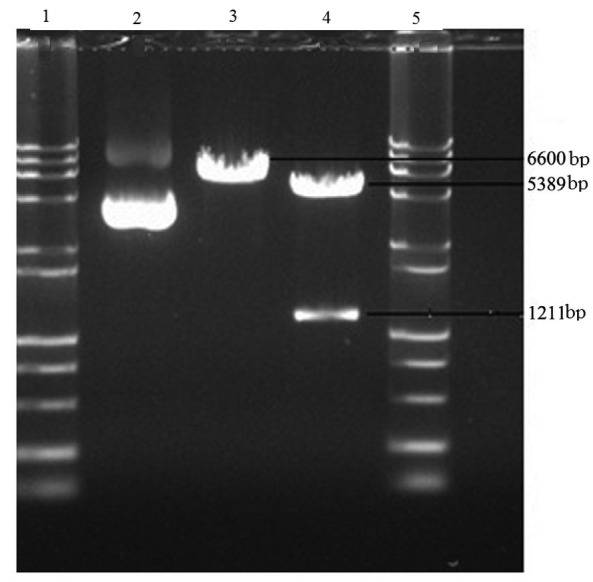
Enzyme electrophoresis of pcDNA3-BMP2. Lanes 1 and 5, DL 15000+2000; lane 2, pcDNA3-BMP2; lane 3, pcDNA3-BMP2/NotI; lane 4, pcDNA3-BMP2/NotI+XbaI. BMP2, bone morphogenetic protein 2.